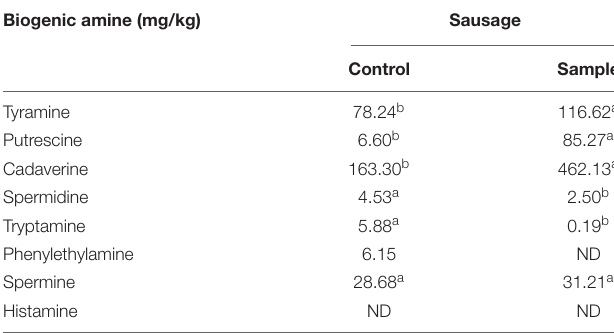
The superscripted letters a b c represent significantly different (p < 0.05) in the same